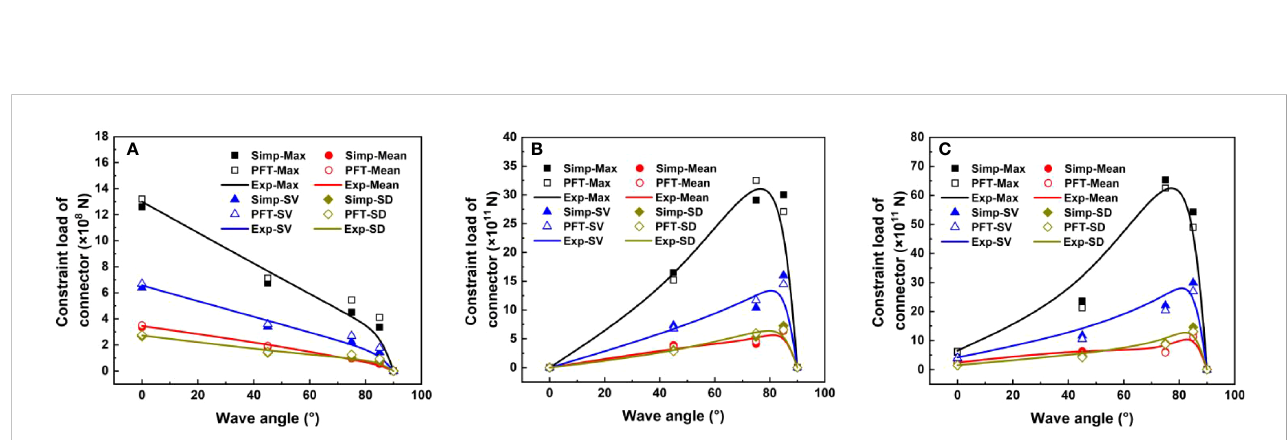
FIGURE 18 Constraint loads of C 1 : (A) x direction; (B) y direction; (C) c direction.